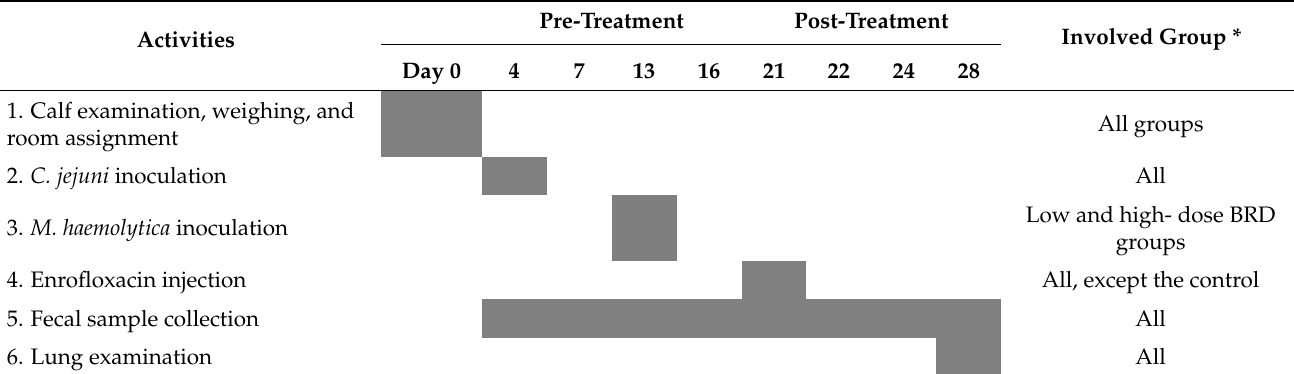
Table 1. Summaries of activities performed during 28 days of the study